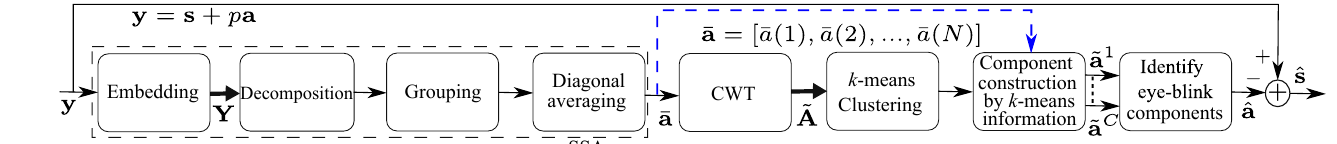
Figure 1. Block diagram of proposed method for eye-blink artifact removal from single EEG